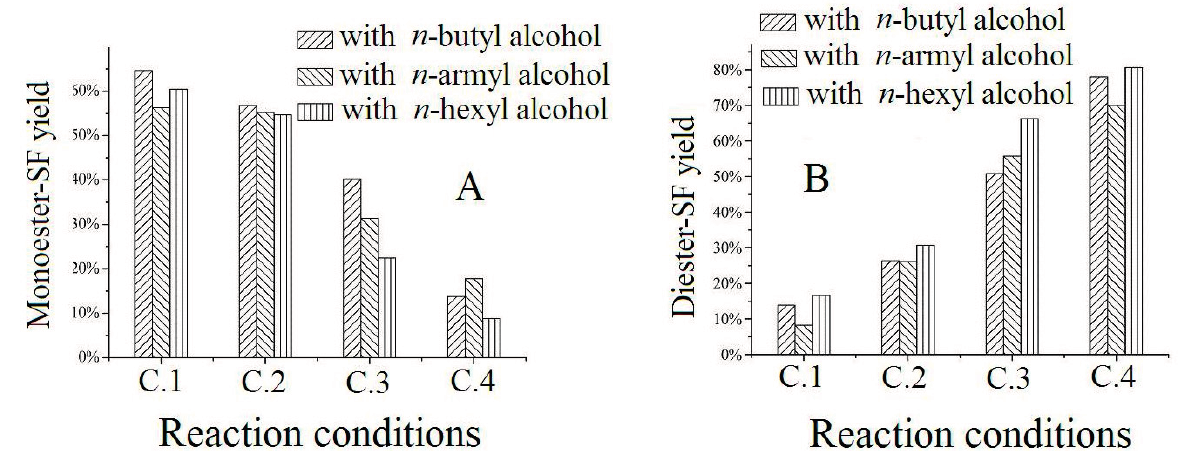
Figure 14. The ratio of ( A ) monoester-SF and ( B ) diester-SF in the product in four reaction conditions. Condition 1: catalyzed by 1 mol/L HCl; reacted for 24 h; Condition 2: catalyzed by 1 mol/L HCl; reacted for 48 h; Condition 3: catalyzed by concentrated HCl; reacted for 24 h; Condition 4: catalyzed by concentrated HCl; reacted for 48